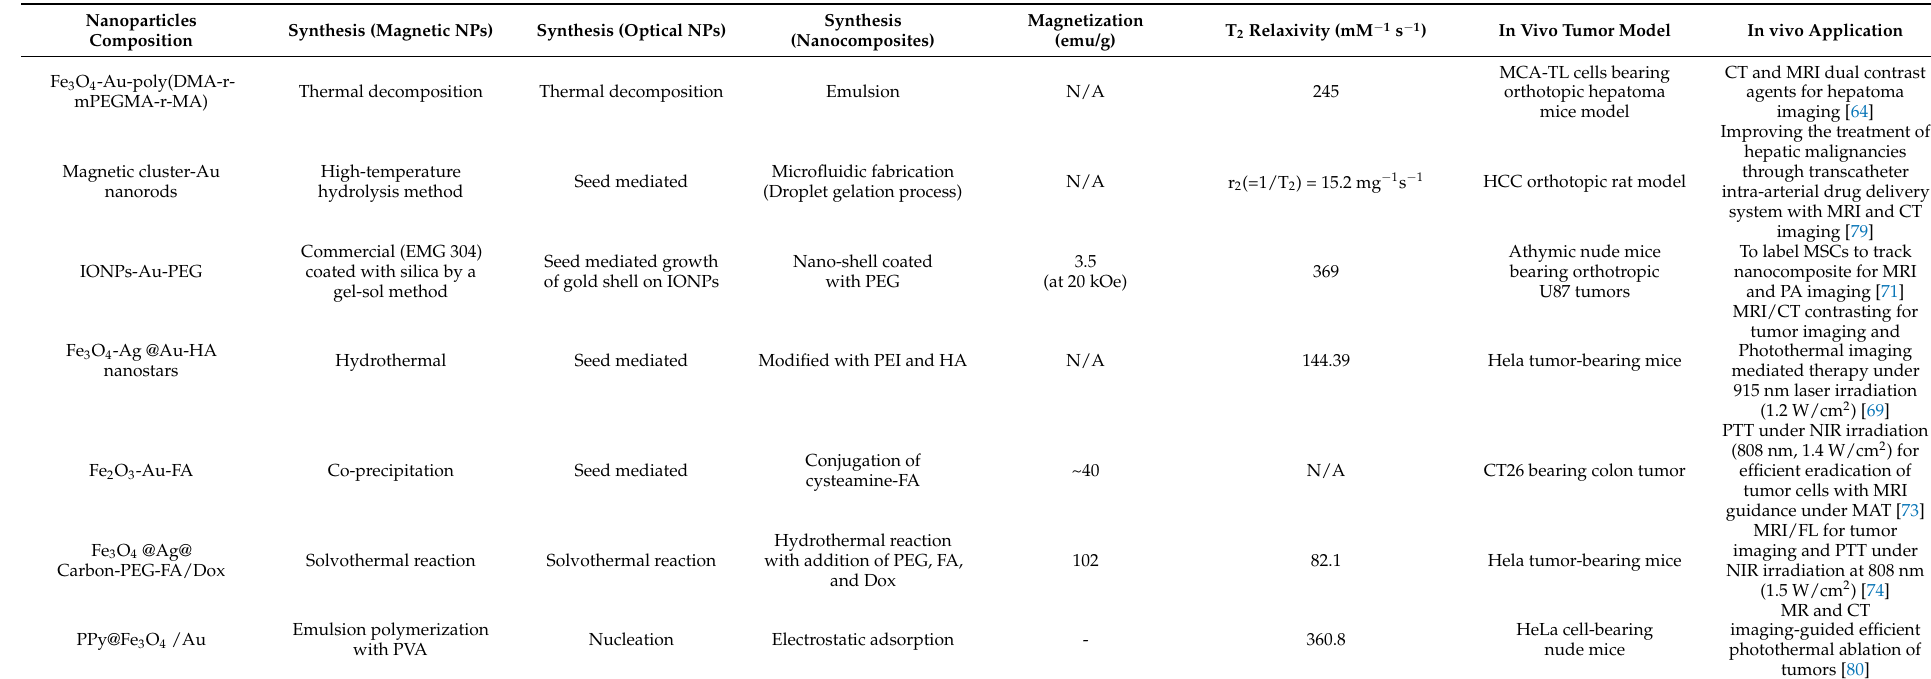
Table 1. Plasmonic nanoparticles—iron oxide nanocomposites for in vivo biomedical